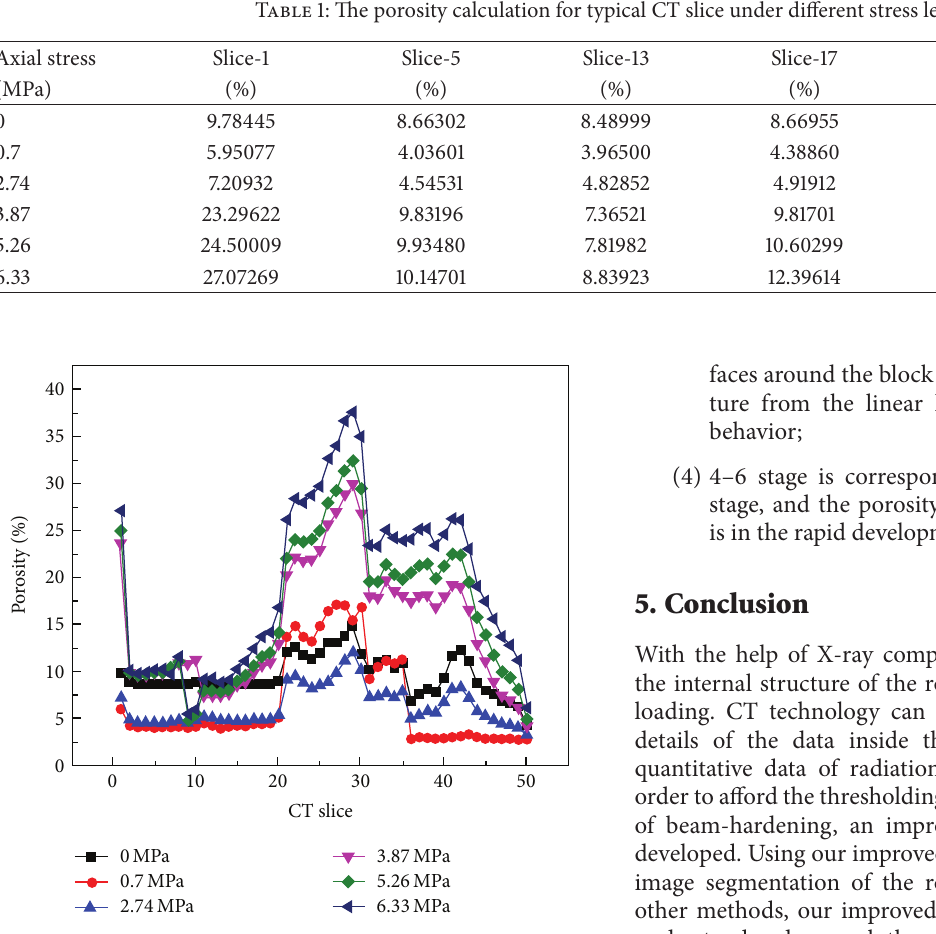
Figure 8: Porosity variation along the 50 slices of the RSA specimen (rock percentage 40%) under five successive stages of compressive